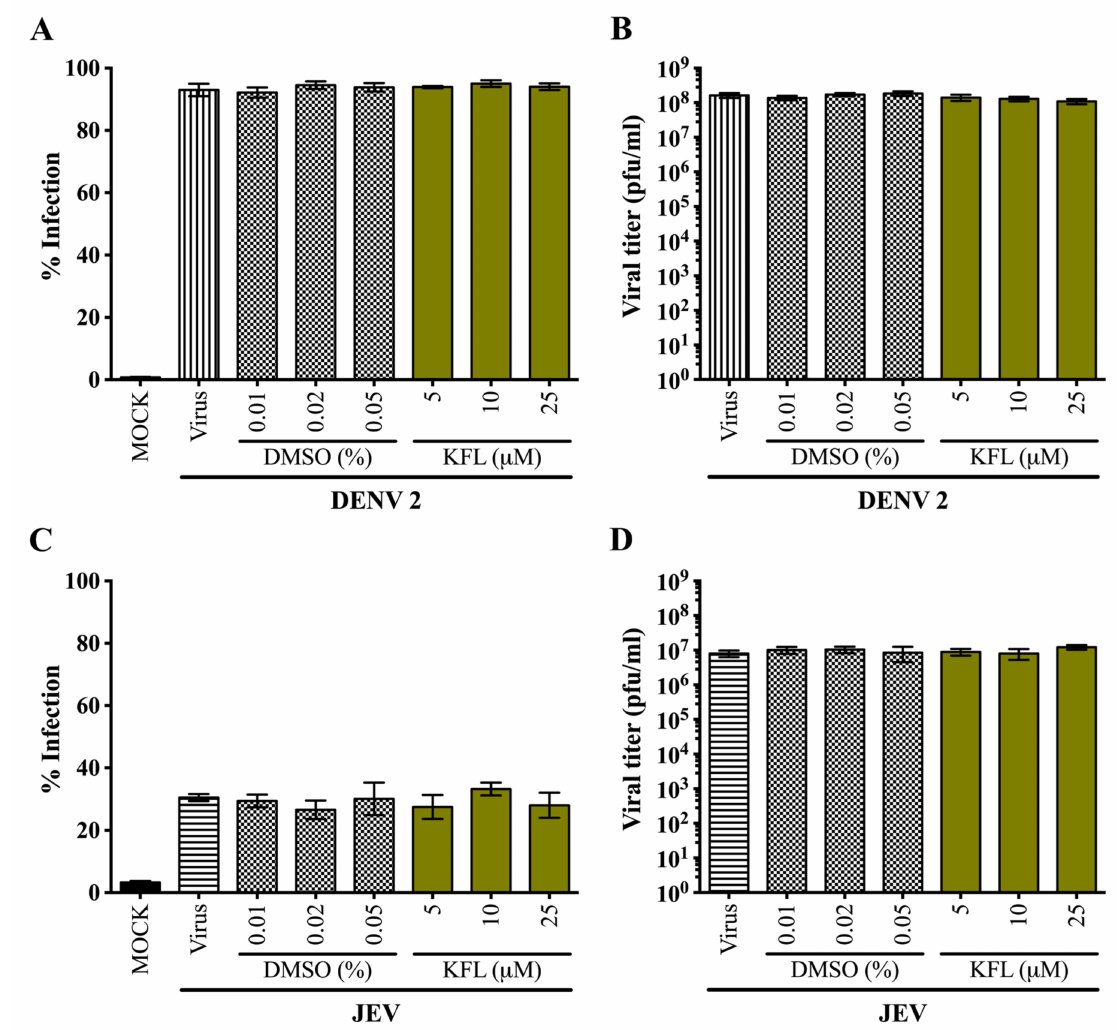
Figure 3. Screening of anti-viral activity of kaempferol against DENV 2 and JEV in HEK293T / 17 cells. HEK293T / 17 cells were infected with either DENV 2 at MOI 5 or JEV at MOI 2. The infected cells were incubated in the presence or absence of various concentrations of kaempferol or parallel concentrations of DMSO vehicle for 24 h. The percentage infection of DENV 2 ( A ) and JEV ( C ) were analysed by flow cytometry. The viral titer in the supernatants of DENV 2 ( B ) and JEV ( D ) were determined by standard plaque assay. Experiments were undertaken independently in triplicate with duplicate standard plaque assay. Error bars show mean ±